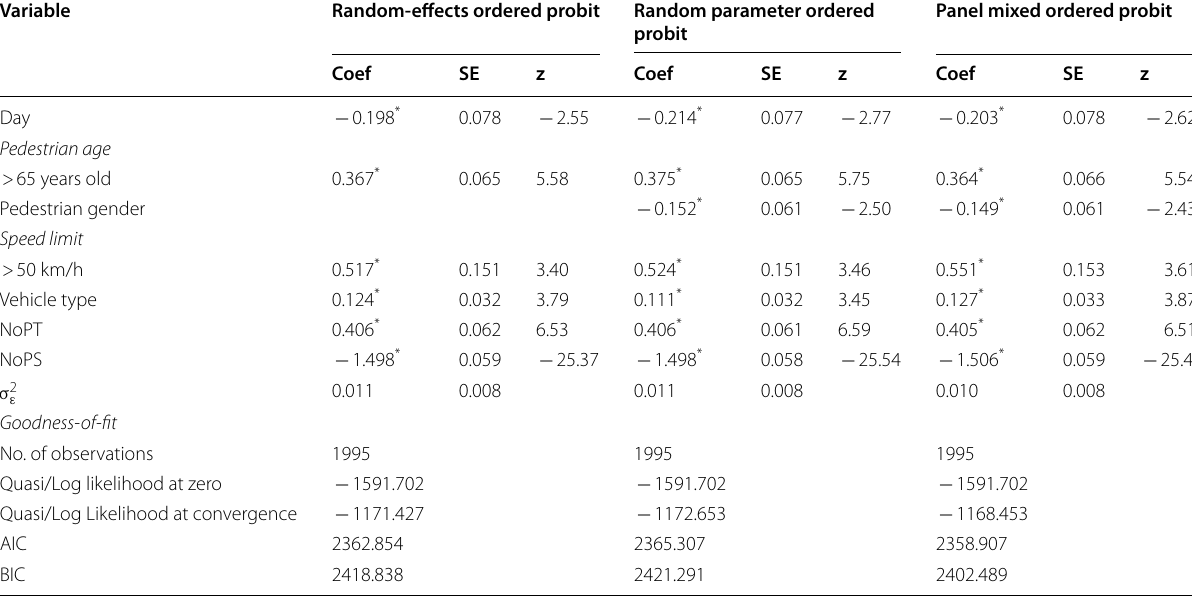
Coef, coefficient; SE, standard